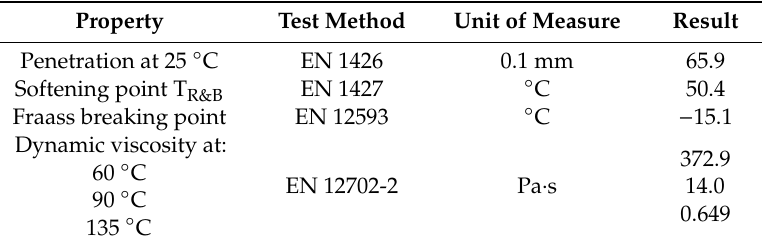
Table 1. Basic properties of 50 / 70 bitumen.